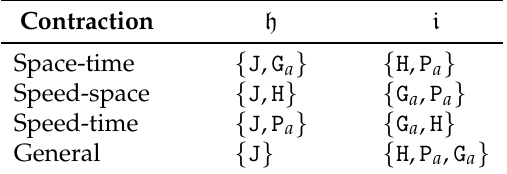
Table 1. The four different ˙Inönü–Wigner contractions classified in